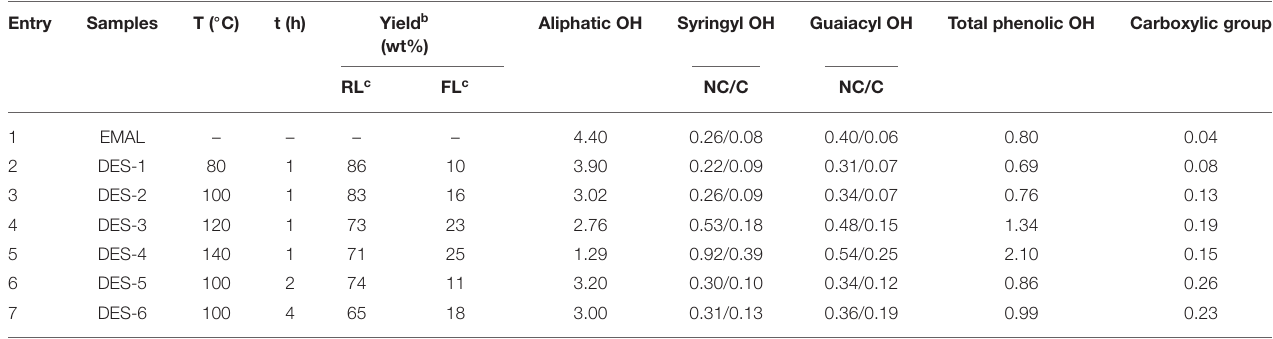
TABLE 1 | ChCl/LA DES-treated Eucalyptus EMAL under various reaction conditions (the unit of hydroxyl and carboxylic group: mmol/g) a